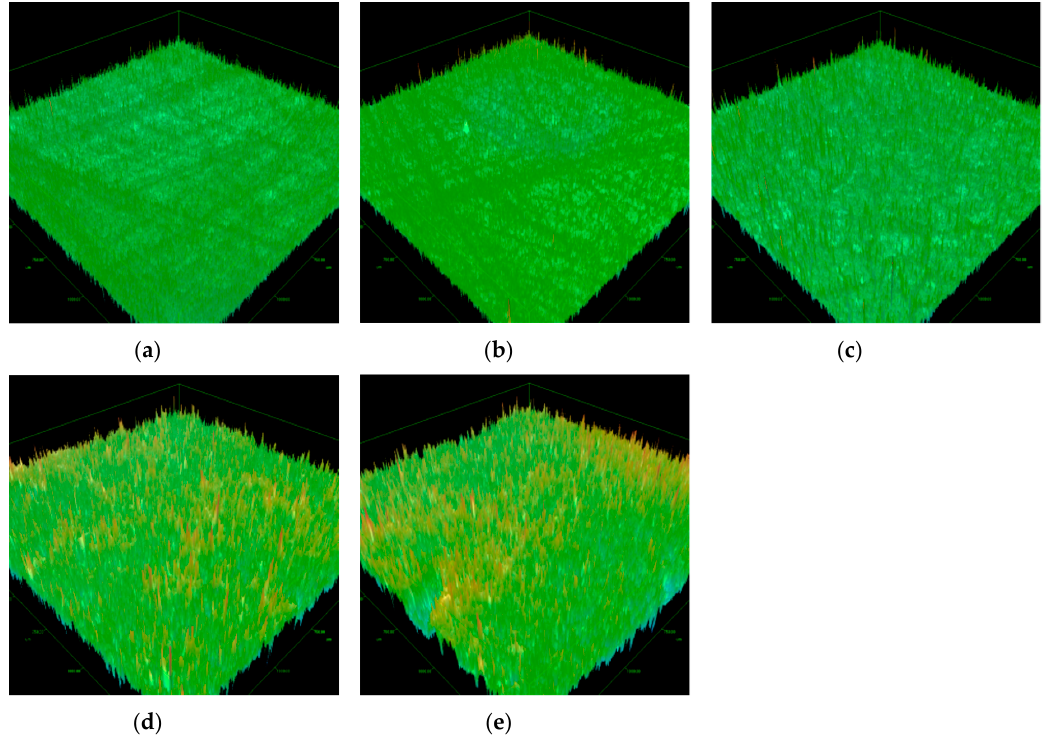
Figure 6. Confocal microscope images of sample surface obtained after completing 80 cycles in the 100-cycle test with 1 mm air gap. ( a ) Sample A; ( b ) Sample B; ( c ) Sample C; ( d ) Sample D; ( e ) Sample E.